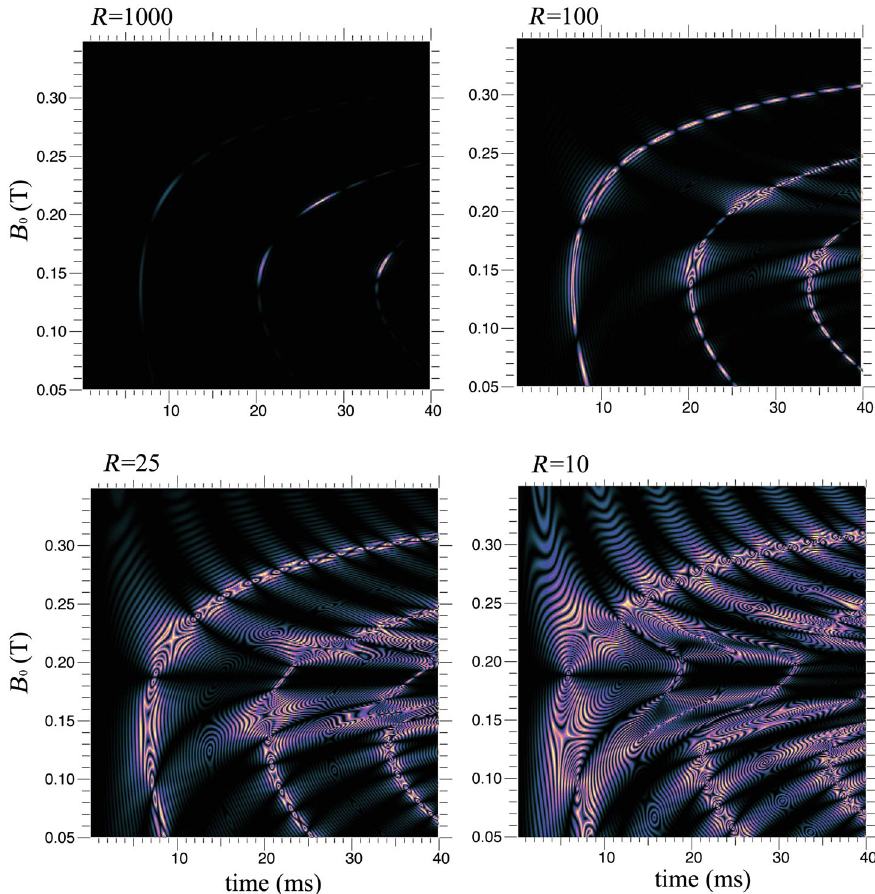
FIG. 3. Coherence decay behavior for an electron spin detecting a flip-flopping pair of nuclear spins, for a donor in silicon system (see Ref. [25]) with tunable interactions. L ð B 0 ; t Þ exhibits a rich structure in the two-dimensional τ , B 0 plane, which is not evident in the normal traces at constant B 0 . Decoherence map is shown for different R ¼ Δ A=C 12 , ð Δ A ¼ A 1 − A 2 Þ . Large R corresponds to weaker dipolar coupling C 12 , and the maps trace the locus of a set of isolated sharp dips in coherence. For smaller R , there are no longer single dips; nevertheless, the envelopes [given by F ð τ Þ ] are well defined and track the behavior of the underlying Floquet avoided crossings. The background oscillatory structure depends on N p , the envelopes do not. Time t ≡ 4 N p τ (color scale linear, where black is 1, yellow is < 0 . 5 ). Similar behavior is obtained for several transitions of Si:Bi and other donors, but specific parameters are for 12 → 9 ESR transition of Si:Bi and 2 N p ¼ 40